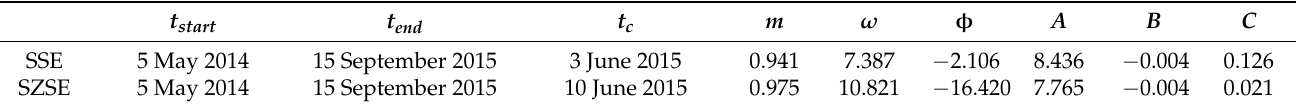
Table 3. 2015 Chinese Bubble LPPL